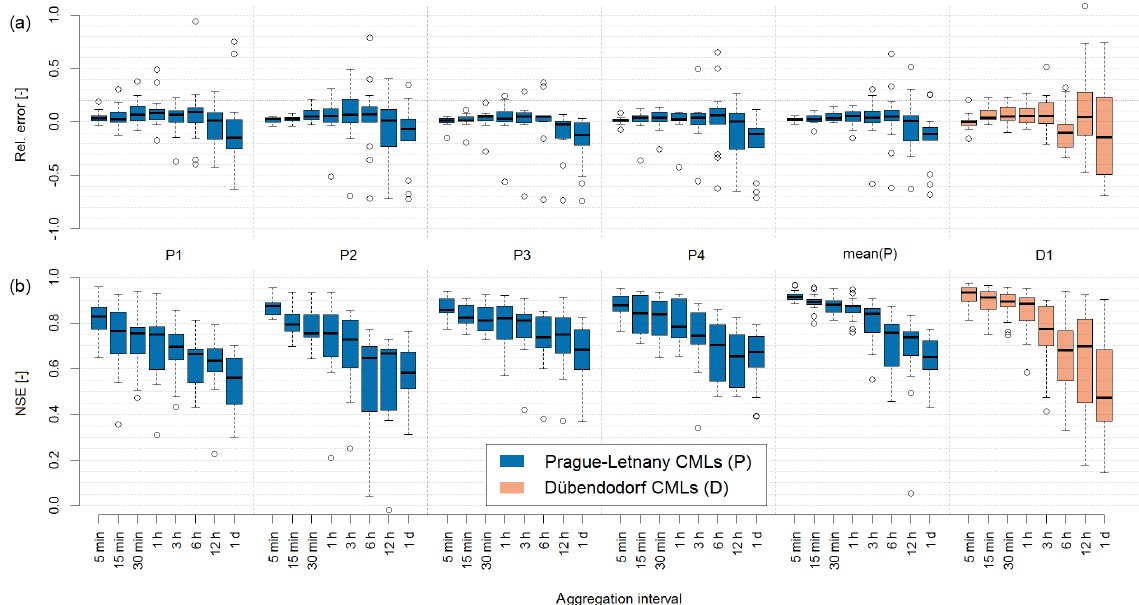
Figure 2. Relative error (top panels) and Nash–Sutcliffe efficiency coefficient (NSE) (bottom panels) in QPEs of CMLs adjusted by rainfall data of different time resolution. Each CML layout is represented by eight box plots corresponding to QPEs adjusted by rainfall aggregated to time intervals from 5min to 1 day. Each box plot depicts a range of the statistics during all evaluated events. Five groups of blue box plots (left panel) evaluate QPEs from single CMLs and from their average at Prague-Letˇnany. One group of orange box plots (right panel) depicts QPEs from a single CML at Dübendorf.